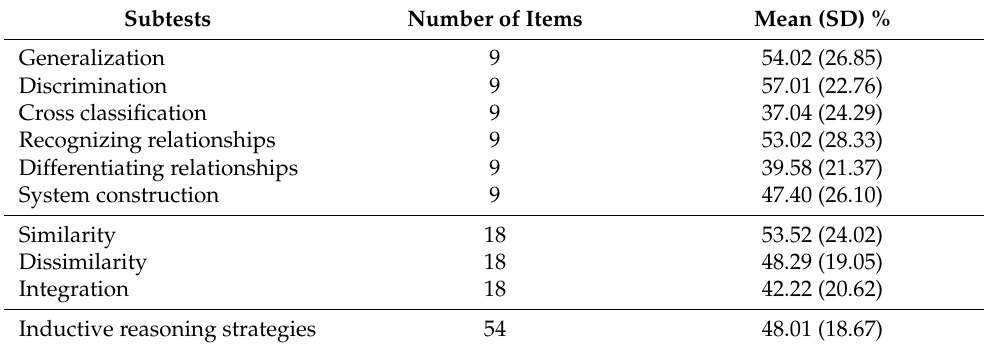
Table 5. Means and standard deviations of the instrument.